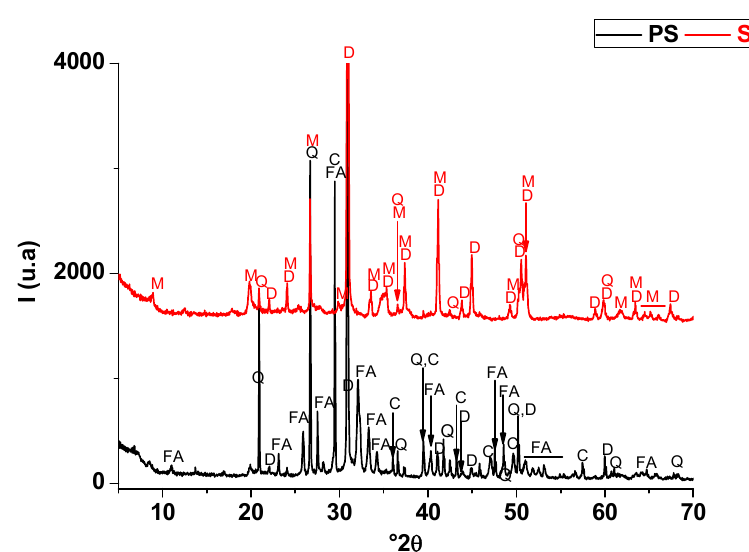
Figure 1. X-ray diffraction patterns of phosphate sludge (PS) and a dolomite-rich clay (SA). FA: fluorapatite (PDF #71-0880); Q: quartz (PDF # 5-0490); D: dolomite (PDF # 83-1766); C: calcite (PDF # 72-1650); M: Muscovite (PDF # 43-0685). Table 1. Mineralogical compositions (wt. %) of studied raw materials. SA: Micaceous raw clay and PS: phosphate sludge. F: Fluorapatite, Q: Quartz, C: Calcite, M: Muscovite, D: Dolomite. Mineralogical Composition F Q D C PS